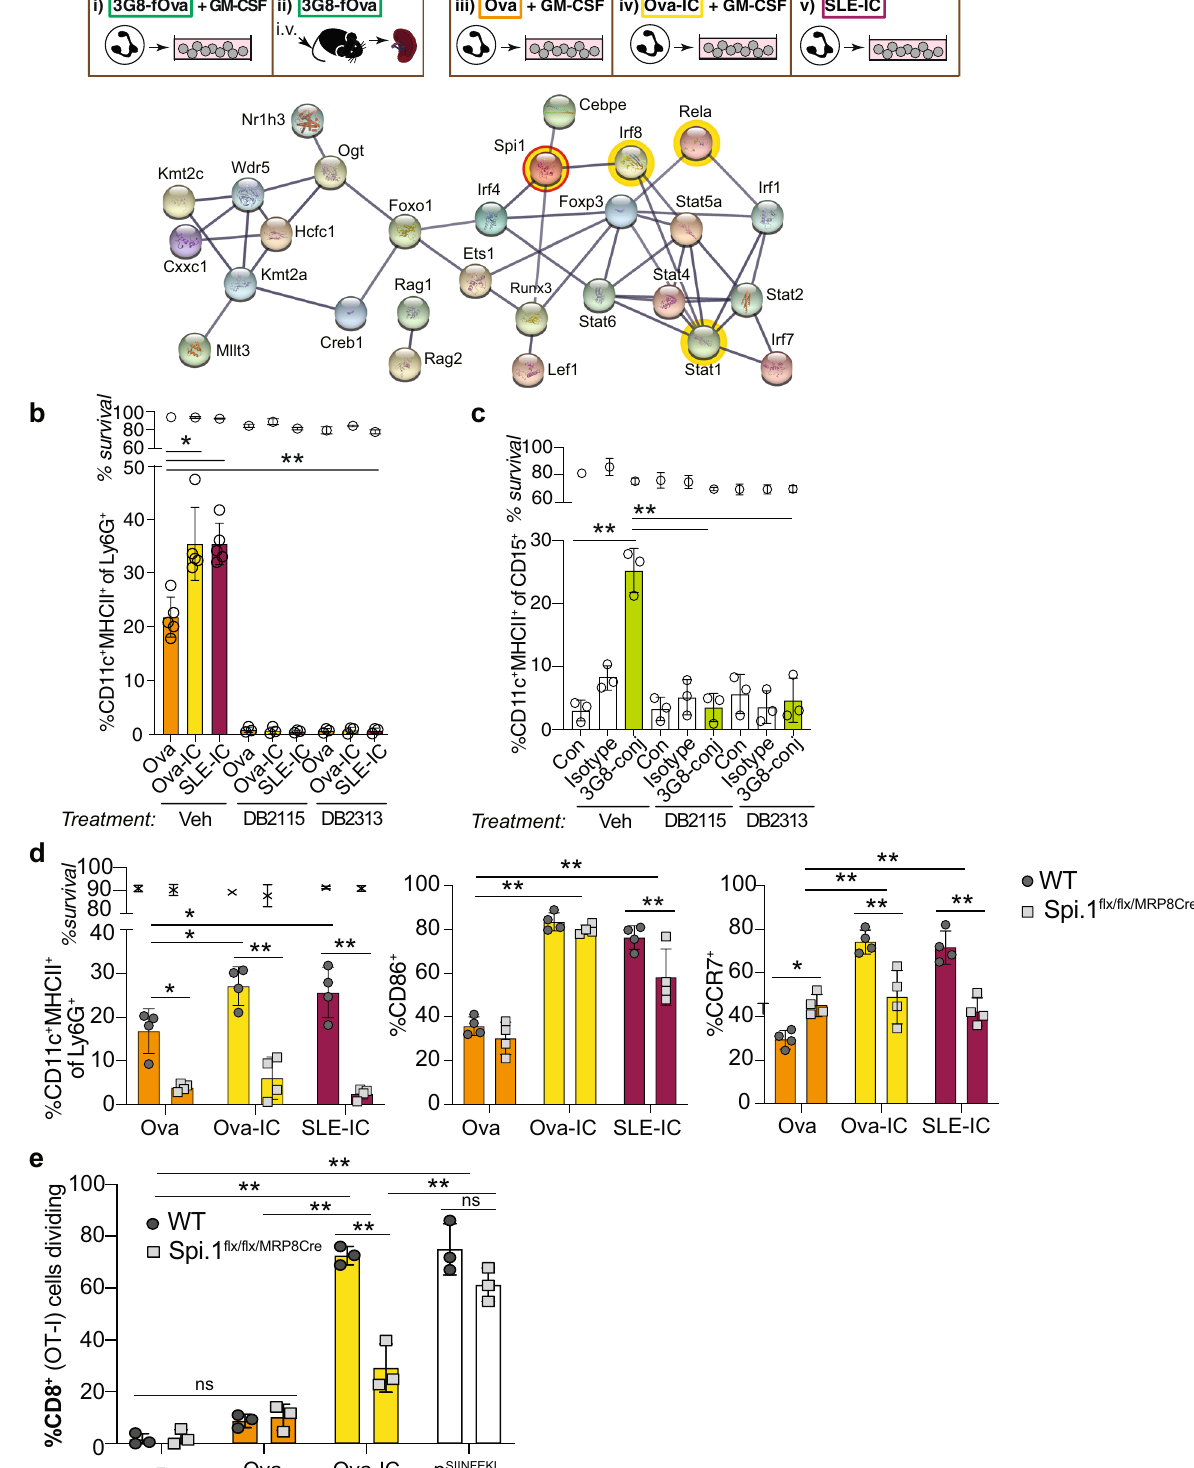
Generation of model immune complexes . To generate immune complexes, volumes of mixtures 1 and 2 are combined to generate a solution of ICs. 10 μ l of this solution is added per 1ml of neutrophil suspensions. solutions containing 2 mg/ml of anti-Ova, anti-NIP-Ova, or anti-BSA antibodies were added to 0.2mg/ml of Ova, FITC-Ova, NIP-Ova, or BSA (mixture 1) or 0.1 mg/ml of Ova, FITC-Ova, NIP-Ova, or BSA in PBS (mixture 2) at a 1:1 ratio and Sera, IgG isolation, and generation of immune complexes with RNP . Peripheral incubated overnight at 37°C to generate IC. The excess antibody in mixtures 1 and blood was drawn into BD Vacutainer ™ Venous Blood Collection Tubes SST. Tubes 2 results in the appearance of a precipitate (insoluble immune complexes). Equal were centrifugated at 2500× g for 30min. Serum was aliquoted and frozen at − 80°C. NATURE COMMUNICATIONS| (2021) 12:4791